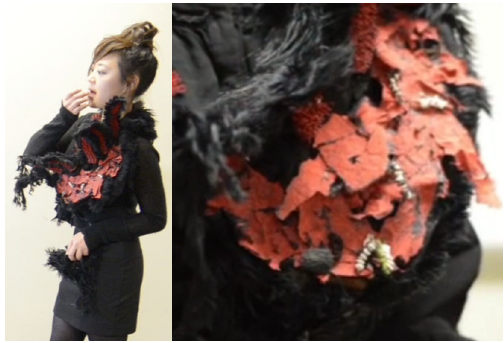
Figure 3. Young Suk Lee. Hatching Scarf